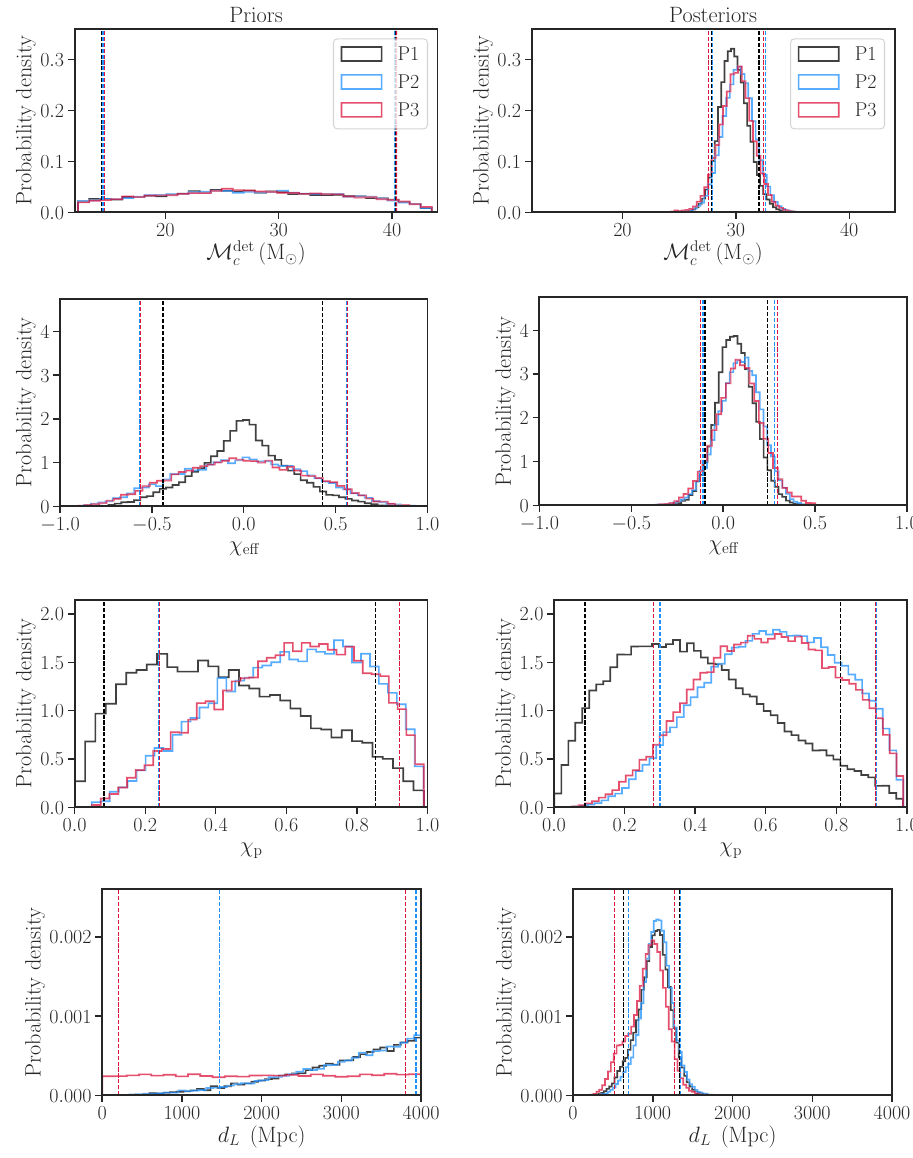
FIG. 17. Example prior and posterior distributions for GW170809. Left column: The four panels show the three different prior choices P1 (black), P2 (blue), and P3 (red) for four different physical parameters: the chirp mass, the effective aligned spin, the effective precession spin, and the luminosity distance. Right column: The four panels show the corresponding posterior probability distributions for the same four physical parameters obtained under the three different prior assumptions P1 (black), P2 (blue), and P3 (red). In all panels, the dashed vertical lines indicate the 90% credible